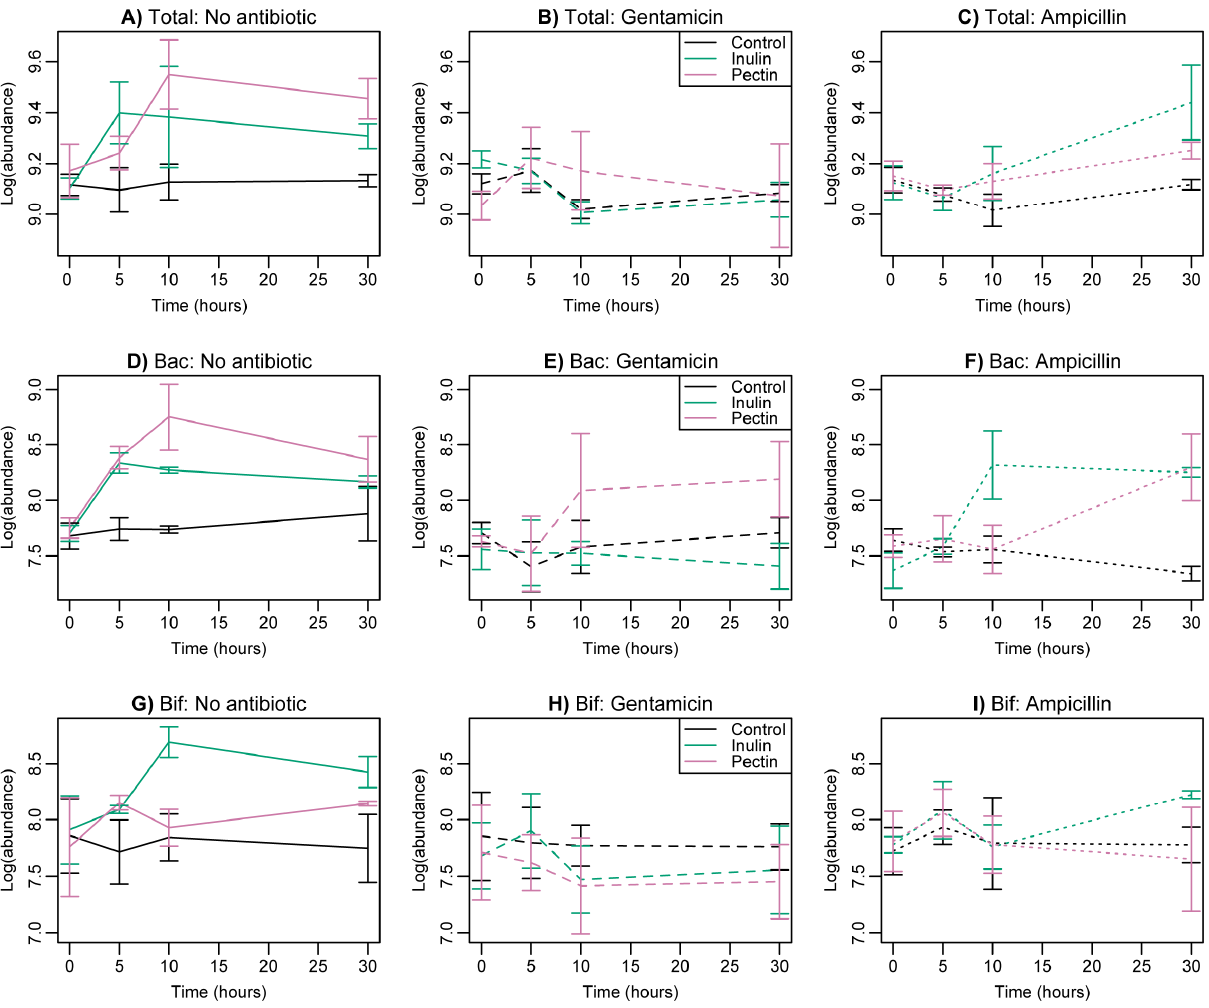
Figure 2 . Changes in the abundance of total bacteria ( A ) to ( C ), Bacteroides ( D ) to ( F ) and Bifidobacterium ( G ) to ( I ) as determined by FISH counts during the course of the experiment. Columns show results with no antibiotics (( A , D , G ), solid lines), gentamicin (( B , E , H ), dashed lines) and ampicillin (( C , F , I ), dotted lines) in turn. Standard error bars are shown. Black = control; green = inulin; red = pectin. Total (total bacterial abundance), Bacteroides (Bac), Bifidobacterium (Bif). Averages across volunteers are